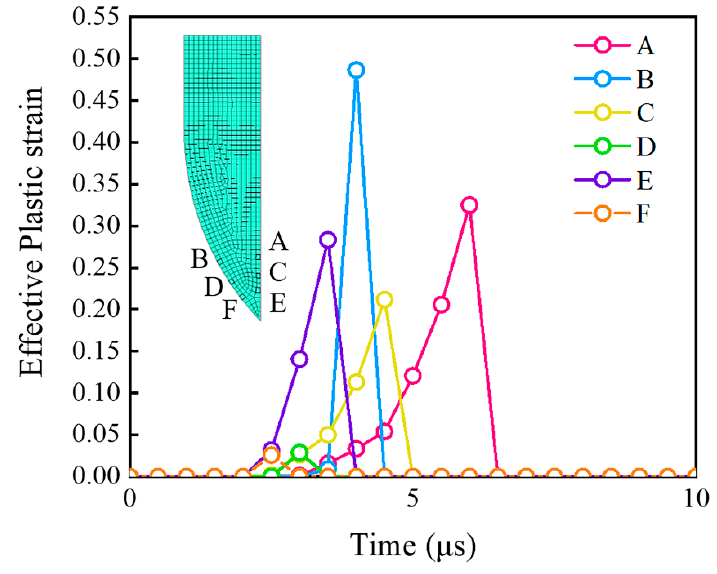
Figure 7. Effective plastic strain curves of typical elements during DU bullet penetration.